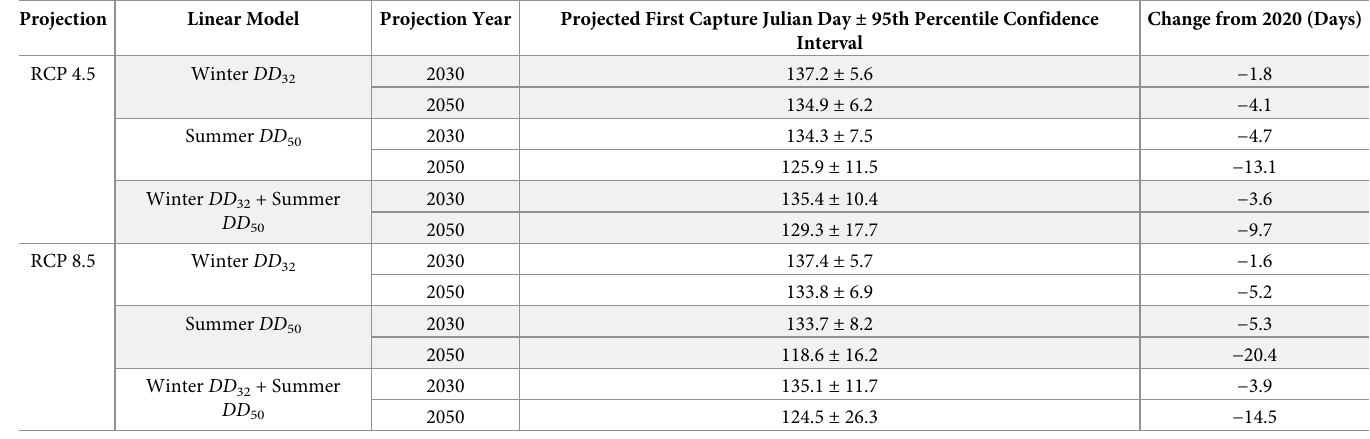
Table 5. Linear model projections and changes of Drosophila suzukii annual first capture days relative to the observed 2020 first capture date under RCP 4.5 and RCP 8.5 for the years 2030 and 2050 with 95 th percentile intervals. Projection Linear